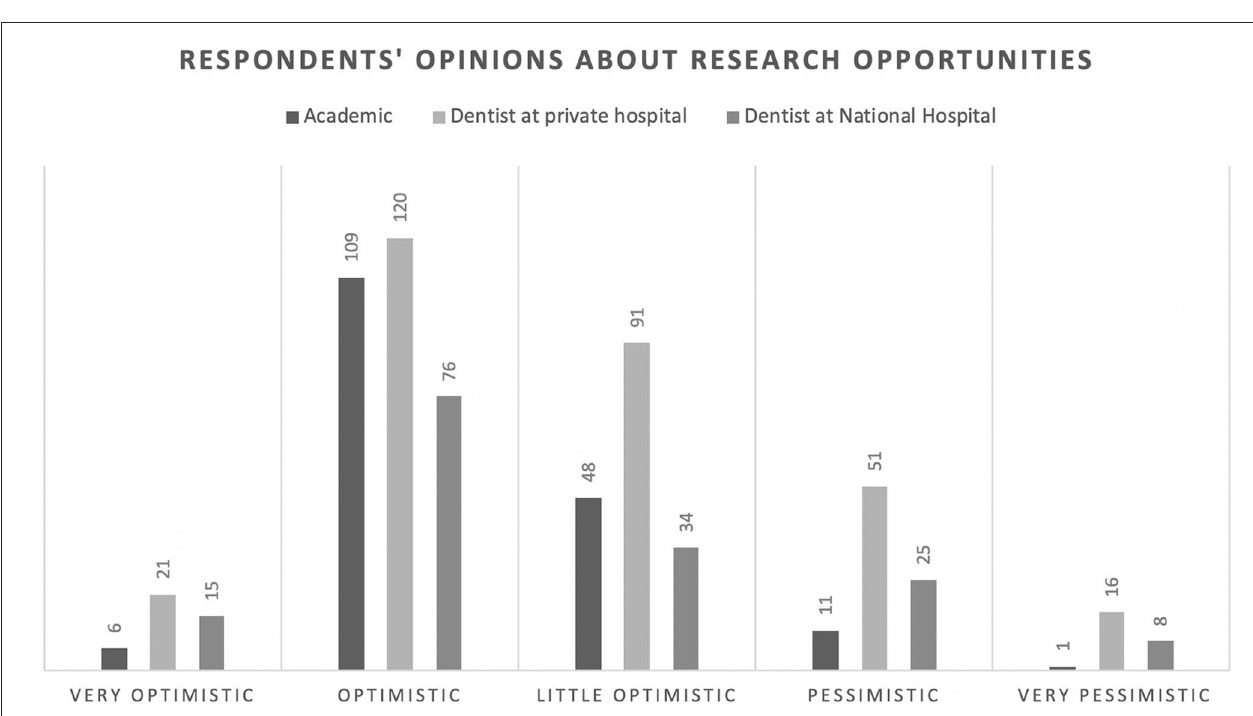
Frontiers in Medicine |